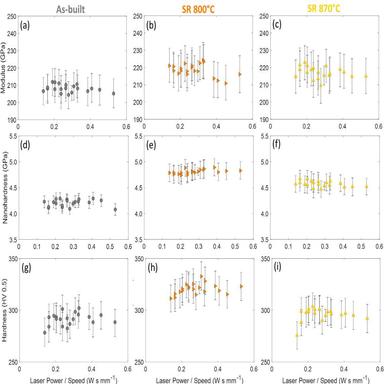
Nanoindentation modulus and hardness and microindentation hardness for rows 1, 2, and 3 respectively. The horizontal axes for every plot are the ratio of laser power to scan speed. Columns are separated by condition: as-built, SR 800 C, SR 870 C. See for a description of the interval calculations. A complete table of the mean, upper, and lower bounds is provided in the supplementary material.